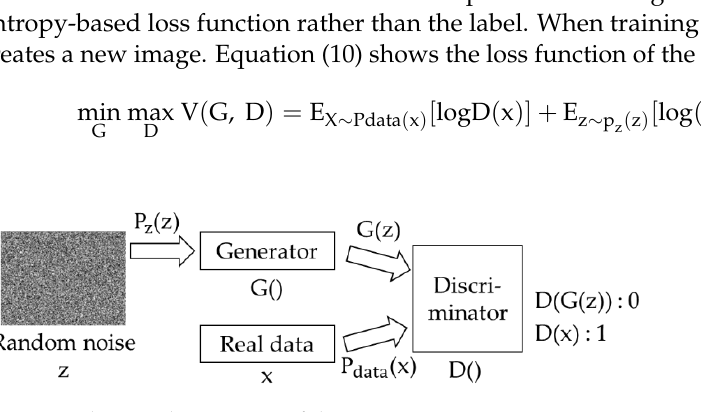
Figure 5. The simple structure of the GAN.